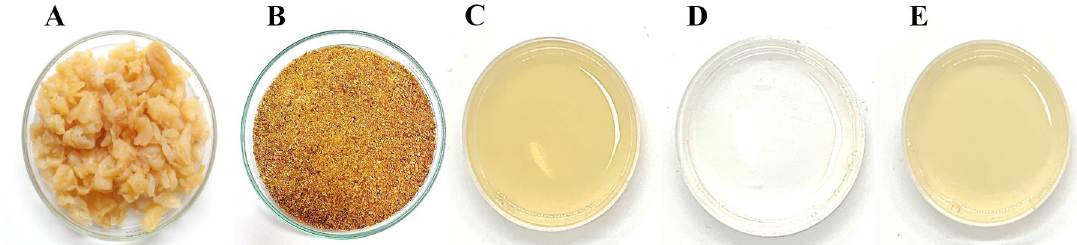
Fig 2. Color of jellyfish samples. (A) desalted jellyfish; (B) dried desalted jellyfish; (C) jellyfish gelatin gel; (D) fish gelatin gel, and (E) bovine gelatin